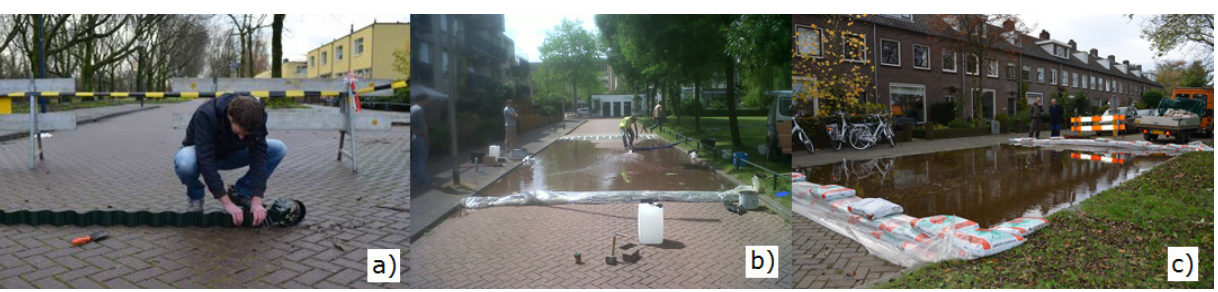
Figure 4. Various dam variations used at the different test locations; ( a ) impermeable barriers; ( b ) plastic wrapped soil core; ( c ) soil-filled plastic